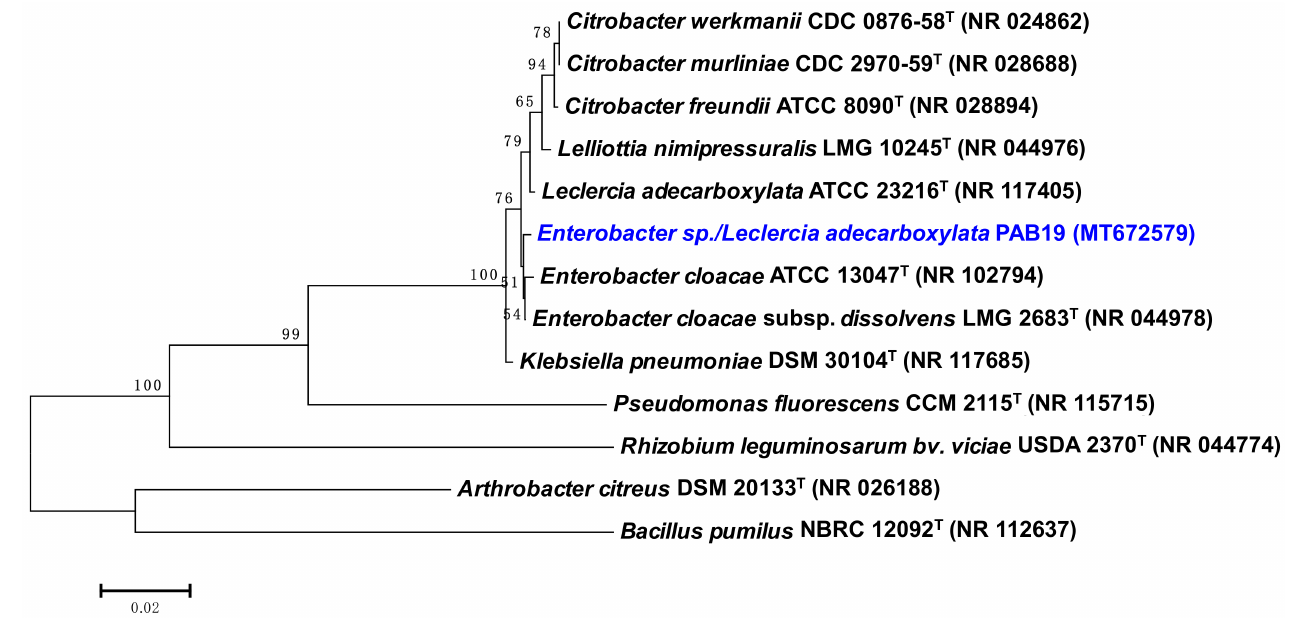
Figure 1. Neighbor-joined phylogenetic tree of Enterobacter sp./ Leclercia adecarboxylata PAB19. The tree was constructed based on 16S rRNA partial gene sequences (taken from NCBI BLAST search tool) from some closely related phylogenetic species (type cultures). Sequences were aligned using the Clustal W sequence alignment tool in MEGA 7.0 software. Bootstrap percentage values as obtained from 1000 replications of the data set are given at nodes. The GenBank accession numbers of isolates and other genera or species are presented in parenthesis. The scale bar corresponds to the mean number of nucleotide substitutions per